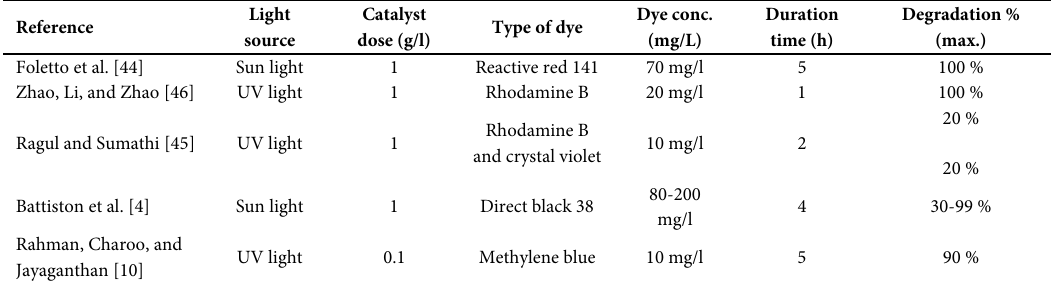
Table 4. summarizes the published literature articles on the photocatalytic degradation of various organic dyes using zinc aluminate as